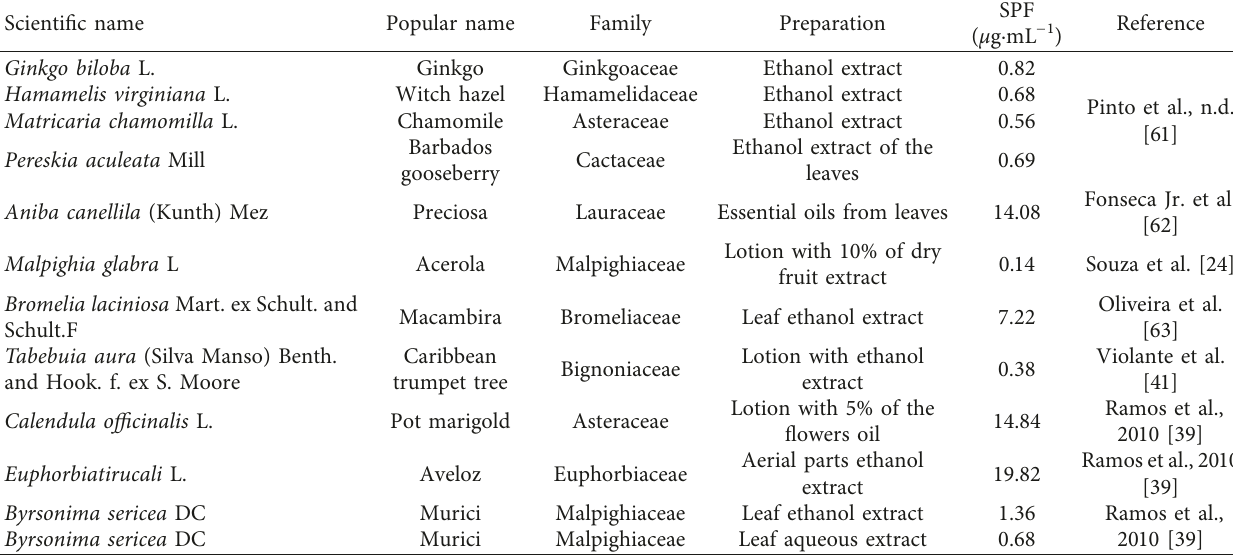
Table 1: Results for some plant extracts for photoprotective activity.